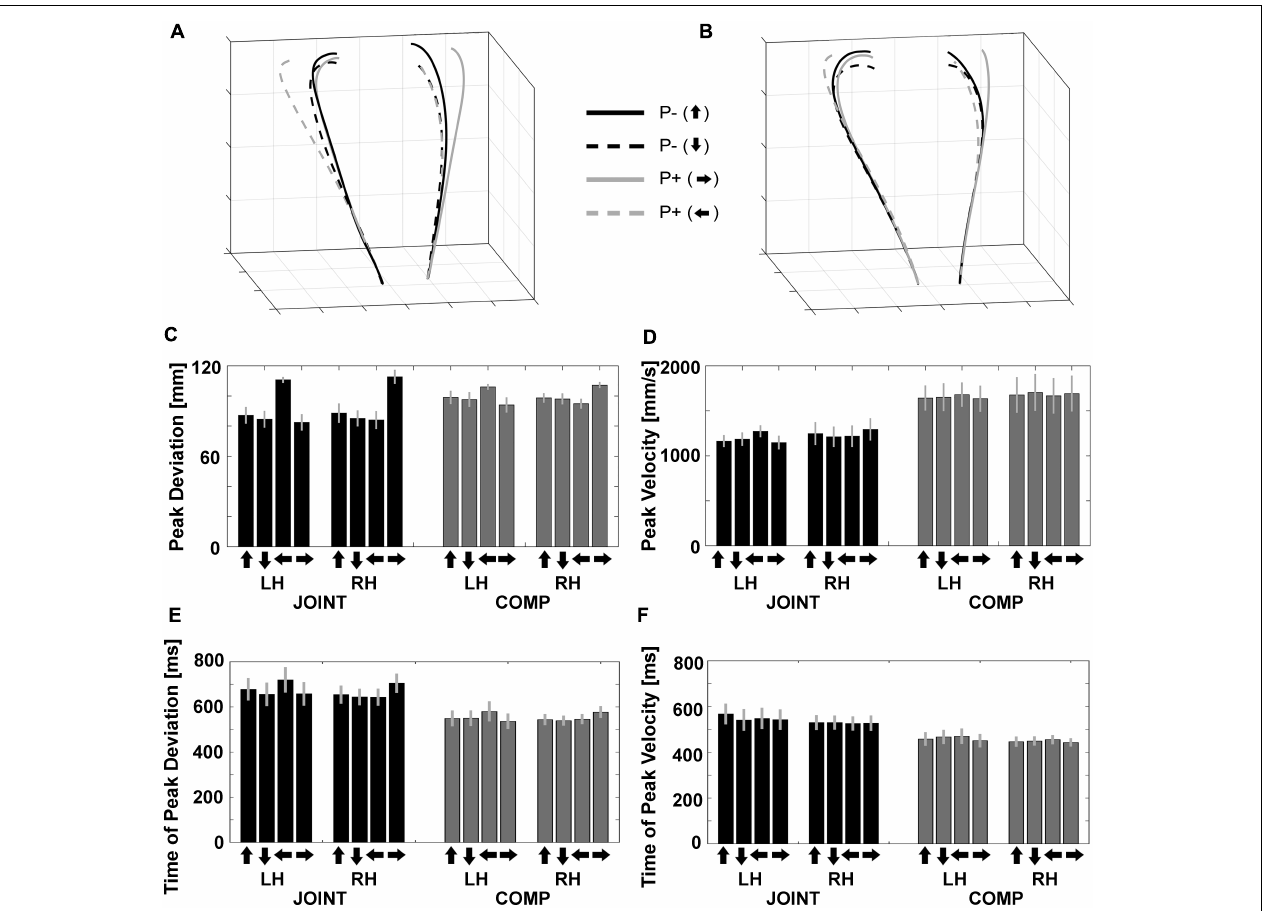
FIGURE 3 | Normalized trajectories of (A) cooperation (JOINT) and (B) competition (COMP) for the left and right hands from movement onset to object contact. P–, no perturbation; P+, perturbation. Arrows pointing up/down/left/right denote object rotations based on the final orientation of the object. (C) Peak deviations of the left (LH) and right (RH) hands during JOINT and COMP. (D) Peak velocities of the left and right hands during JOINT and COMP. (E) Peak deviation times of the left and right hands during JOINT and COMP. (F) Peak velocity times of the left and right hands during JOINT and COMP. Arrows denote end positions of objects after the respective up-/down-/left-/rightward